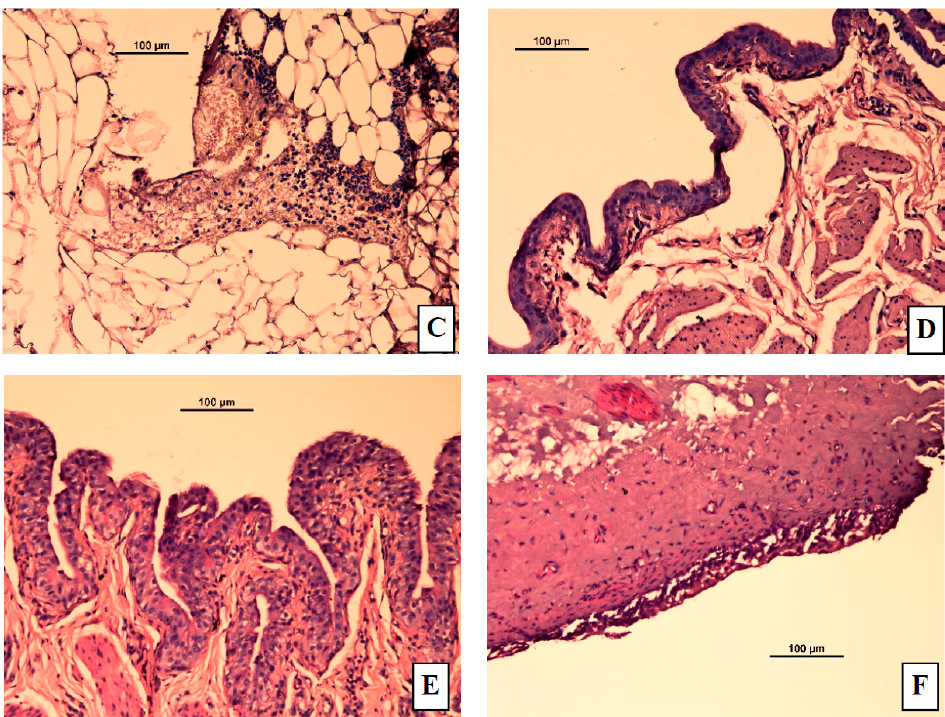
Figure 7. Representative micrographs from rat bladders immediately after micturition studies. ( A ) Control (normal) group ( B ) Acetic acid treated group showing edema ( C ) Acetic acid treated group showing necrosis and ulceration ( D ) Acetic acid treated group given tolterodine by oral ( E ), S1 gel, or ( F ) S3 gel formulations. In the S1 gel treated group, the transitional epithelium regenerated quickly and in the S3 gel treated group, the bladder structure is similar to that in S1 but with more mild mucosa ulceration and scattered inflammation.